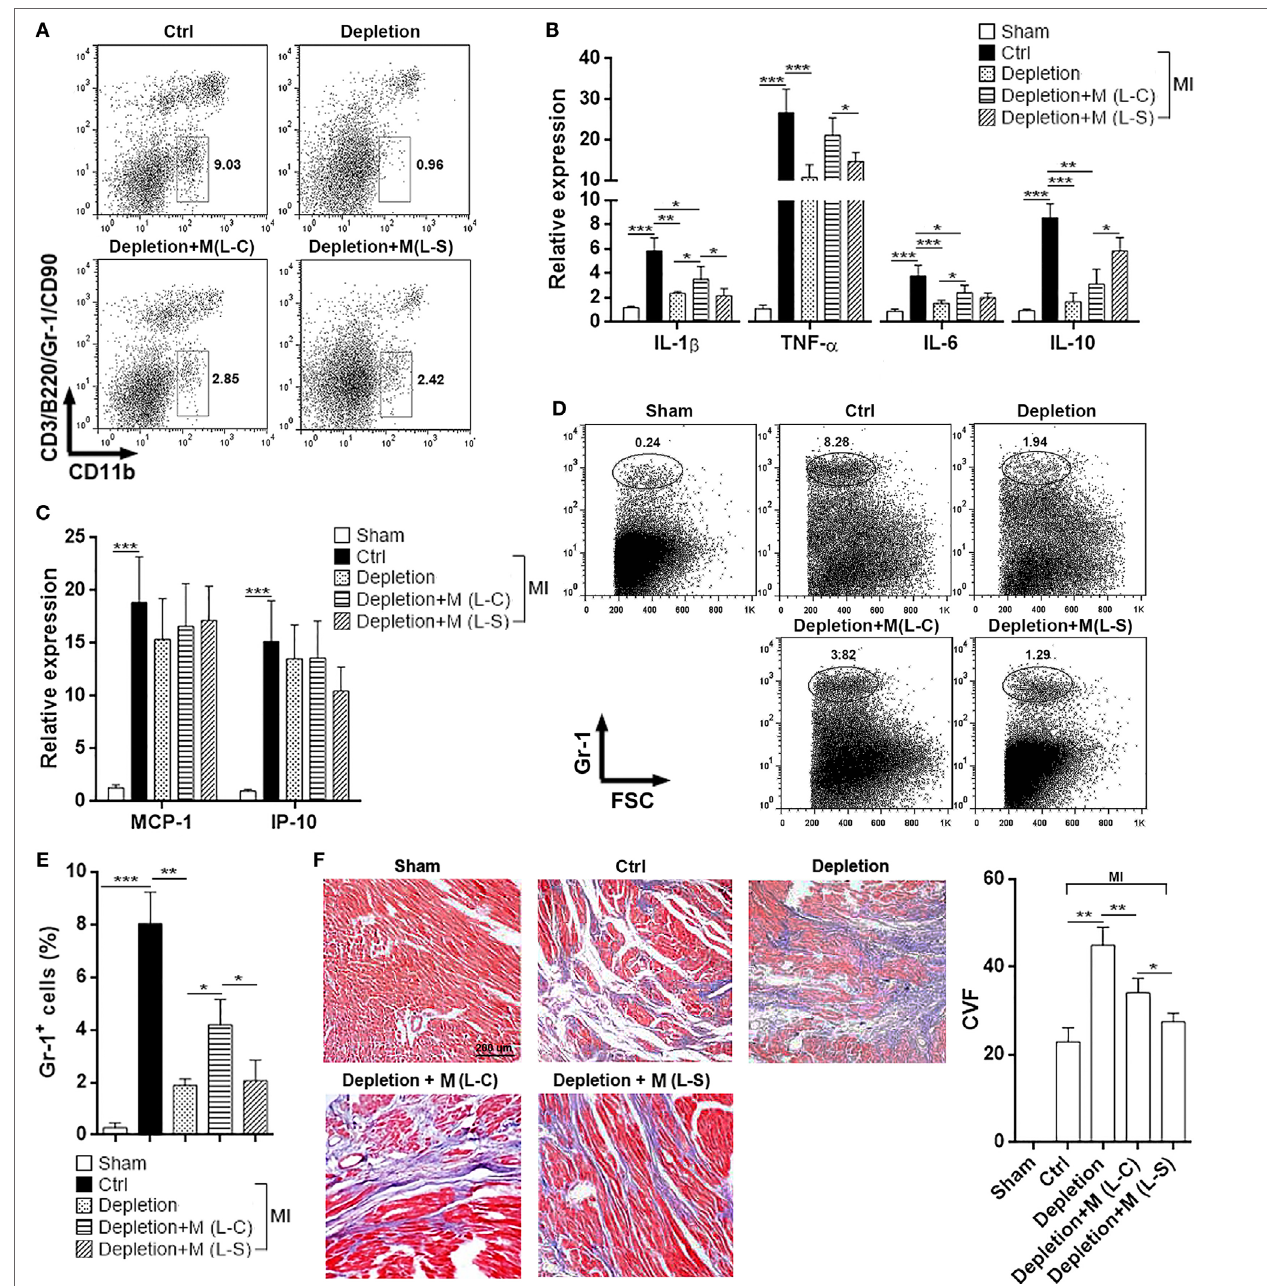
FigUre 5 | Ectopic Sestrin2 expression in M1 macrophages attenuates post-MI inflammation and favors tissue repair in hearts. (a) Macrophage abundance in infarcted myocardium at day 3 after myocardial infarction (MI) (day 4 after Clophosome ® treatment). Ctrl: un-pretreated mice. Depletion: Clophosome ® injection. Depletion + M (L-C): Clophosome ® injection followed by transfer of M1 macrophages transduced with control lentivirus. Depletion + M (L-S): Clophosome ® injection followed by transfer of M1 macrophages transduced with SESN2 lentiviral activation particles. Numbers in the plots are proportions of gated cells populations. This is a representative of two independent experiments. (B,c) mRNA abundance of indicated cytokines and chemokines in infarcted myocardium. (D,e) Percentage of Gr-1 + neutrophils in the whole cardiac cells at day 3 after MI. Representative flow cytometry dot plots are shown in (D) , and statistics is shown in (e) . (F) Masson staining at day 7 after MI. Left panel: representative images. Right panel: statistics of collagen volume fraction (CVF). N = 4–5 per group. * p < 0.05; ** p < 0.01; *** p <